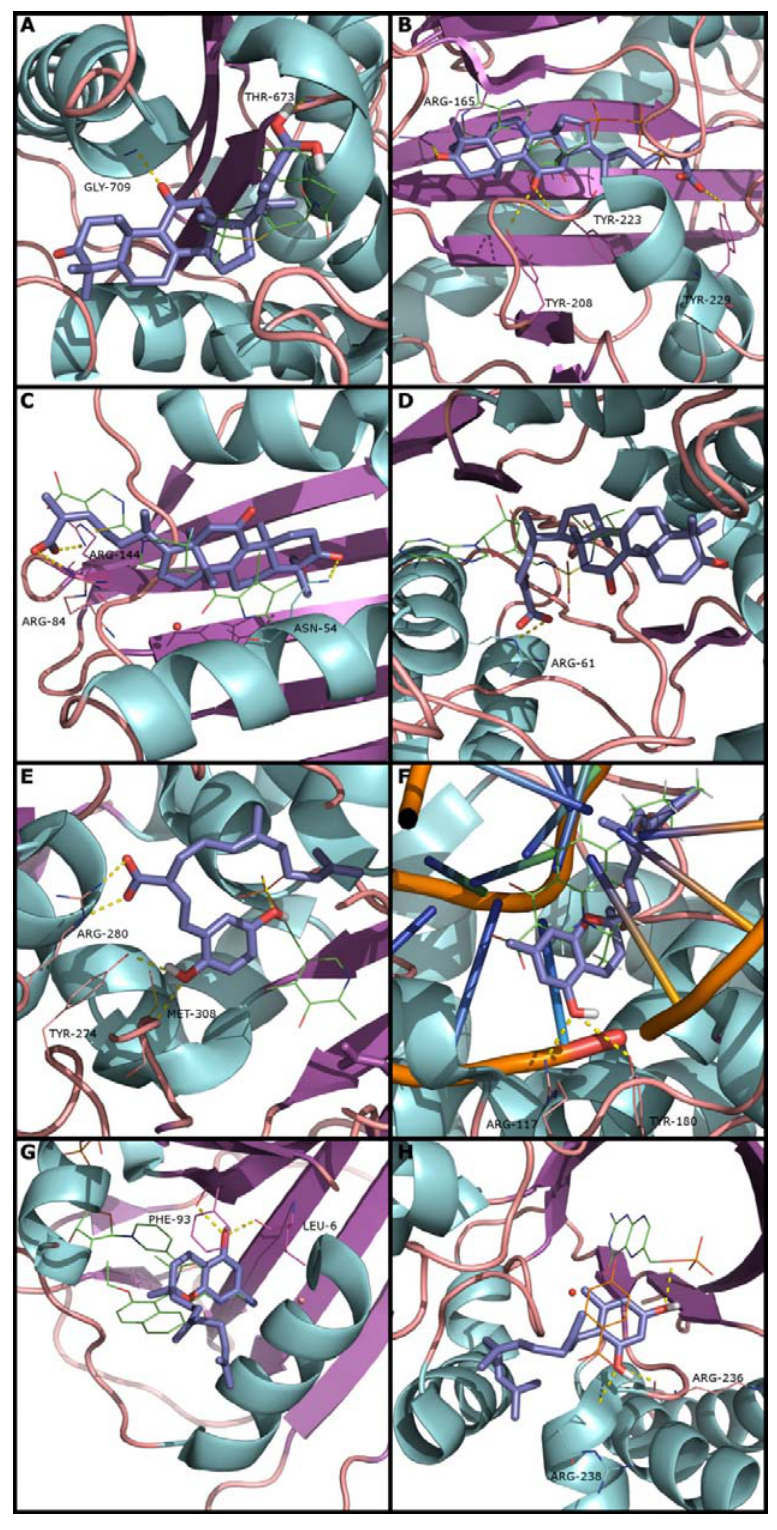
Figure 2. Docking pose: PBP1a ( A ), Ddl ( B ), DNA Gyrase ( C) and IARS ( D ) with 3,11-dioxolanosta-8,24(Z)-diene-26-oic acid; Alr ( E ) with ganomycin B; TopoIV ( F ) and DHFR ( G ) with confluentin; DHPS with neogrifolin ( H ). All the proteins are presented in cartoons, the predicted poses are presented in purple sticks and co-crystallized ligands presented in green lines. In 2H, p-hydroxybenzoic acid (orange line), which is a ligand co-crystallized with the other DHPS structure (3TYB), is